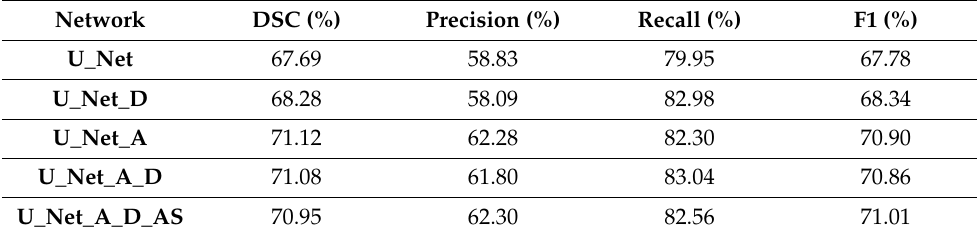
Table 6. Test results of English character map.